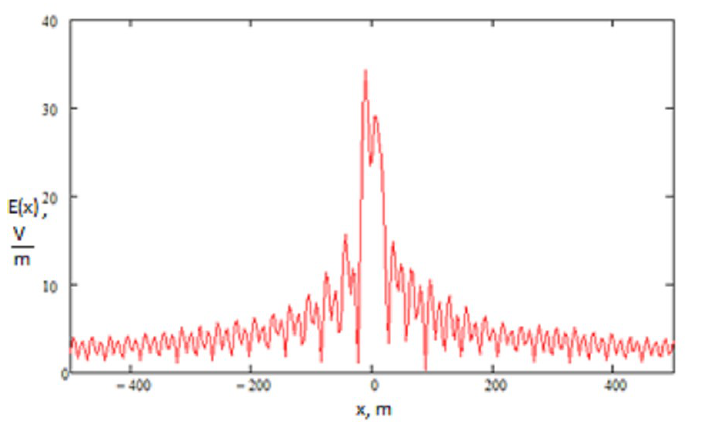
Fig. 2. Amplitude distribution of point source field for the frequency of 10 MHz